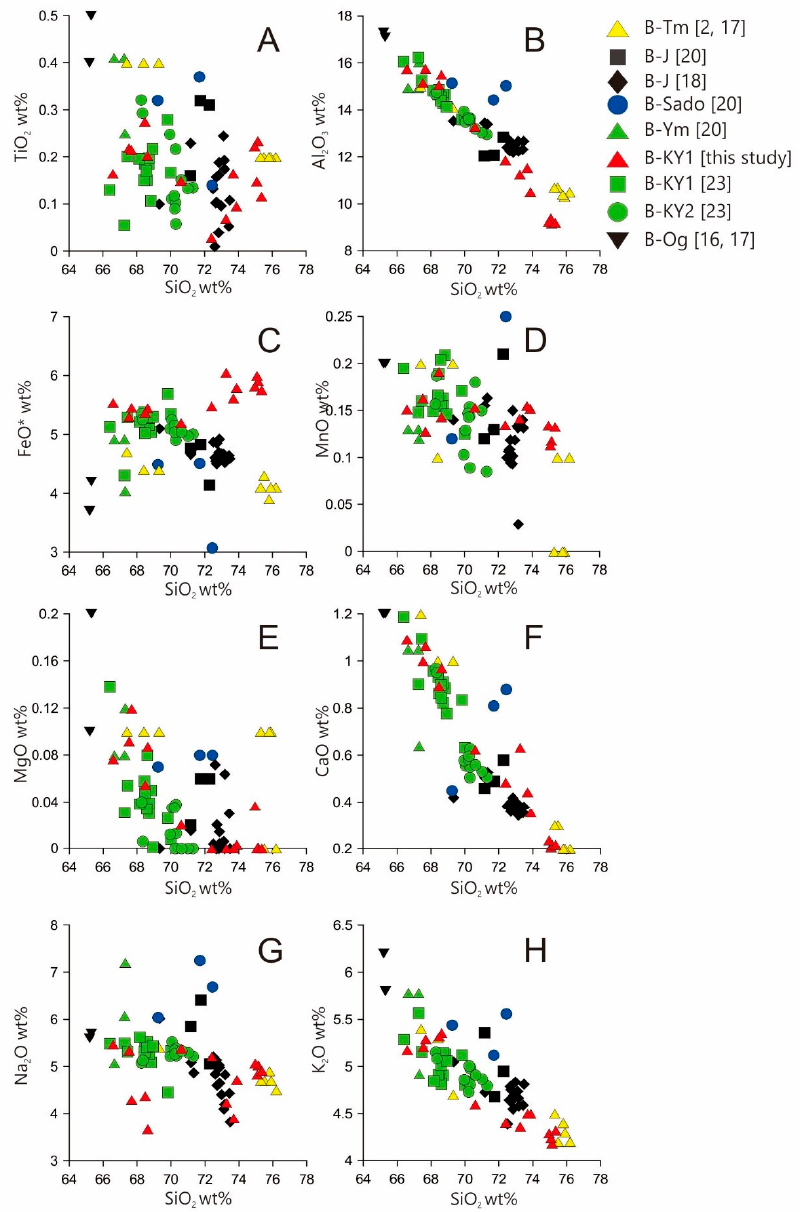
Figure 7. Major element variation diagram of selected elements versus silica from B-KY1 tephra and other Baekdusan tephra samples (Data from [2,16–18,20,23]). ( A ) TiO 2 versus SiO 2 , ( B ) Al 2 O 3 versus SiO 2 , ( C ) FeO * versus SiO 2 , ( D ) MnO versus SiO 2 , ( E ) MgO versus SiO 2 , ( F ) CaO versus SiO 2 , ( G ) Na 2 O versus SiO 2 , ( H ) K 2 O versus SiO 2 .